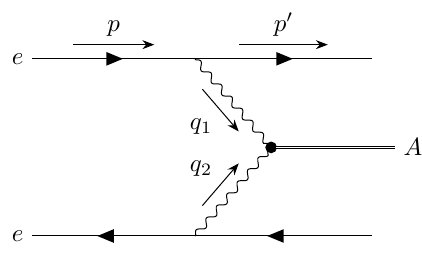
Figure 3 . Feynman diagram for two-photon hadron formation in electron-positron